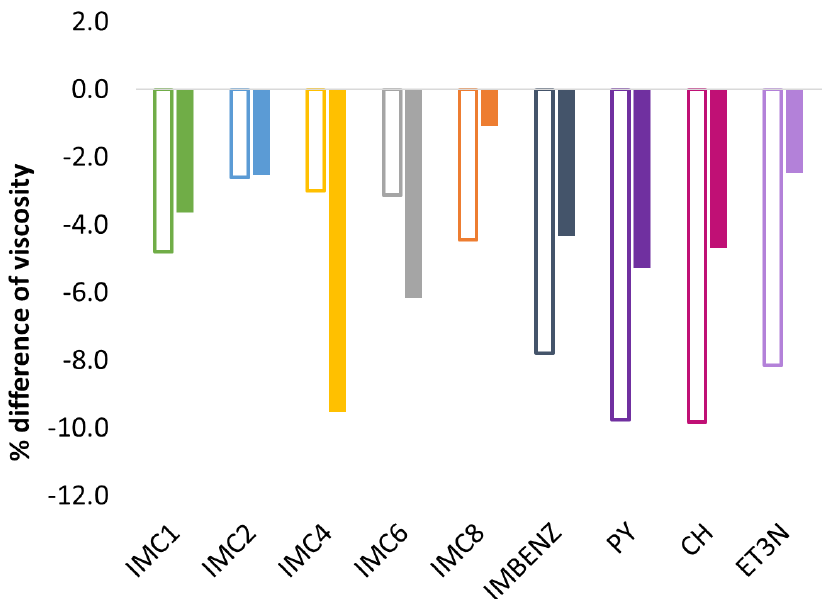
Figure 9. Δ viscosity (in %) of GDILs in [C 2 mim][NTf 2 ] solution compared to the pure ionic liquid at 25 °C. Open bars—open form GDIL (no irradiation) and full bars—closed form GDIL (upon UV irradiation, 240 min).